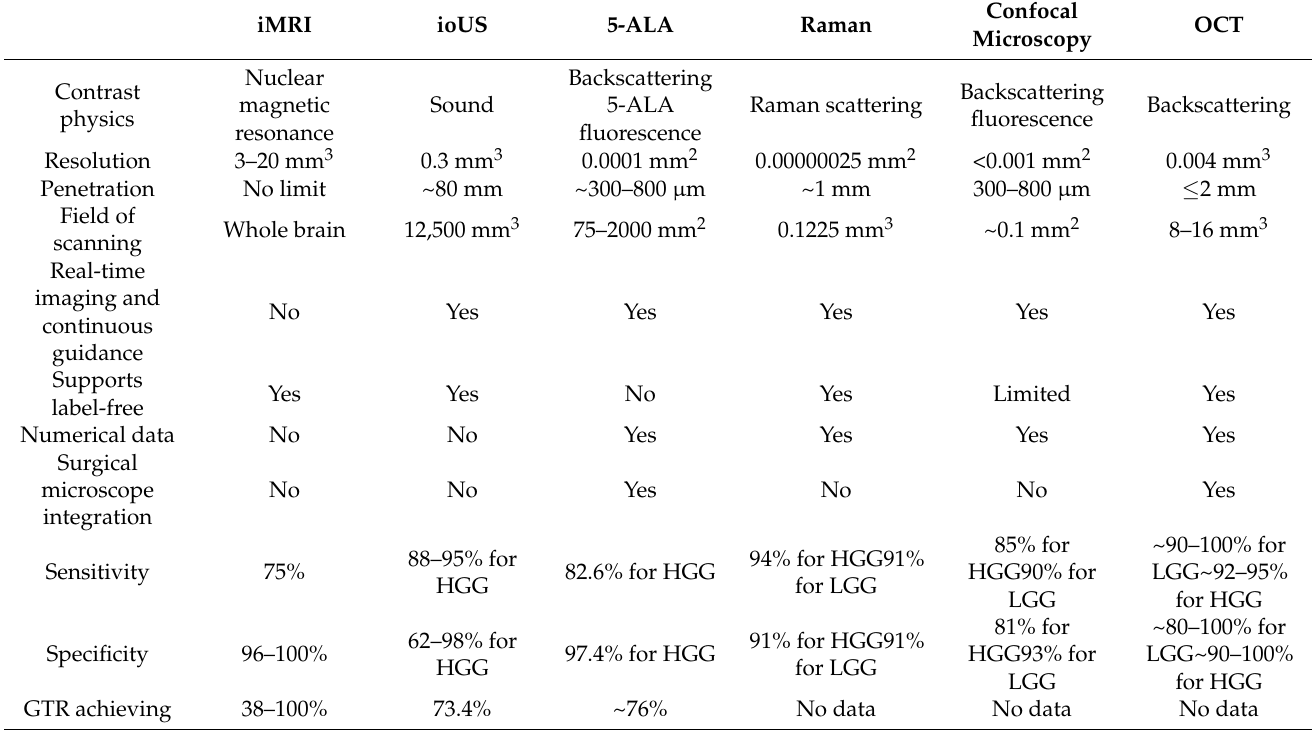
Table 2. Comparison of different technologies in surgical guidance of